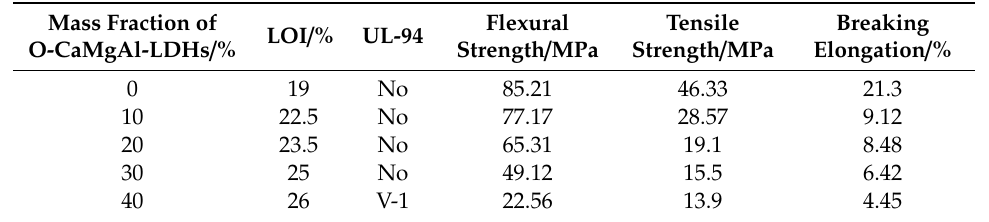
Table 2. The flame retardant and mechanical performances of the ABS composites with various amounts of added O-CaMgAl-LDHs.